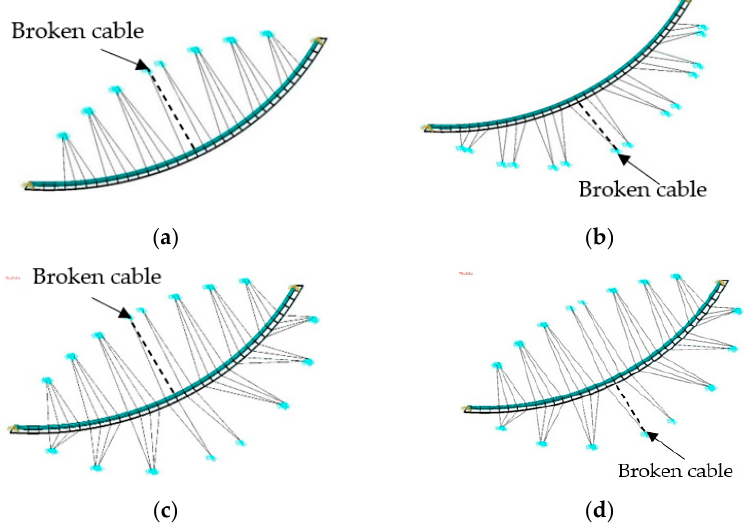
Figure 6. Diagram of stayed cable cases: ( a ) stayed cables case 1; ( b ) stayed cables case 2; ( c ) stayed cable cases 3; and ( d ) stayed cable cases 4.